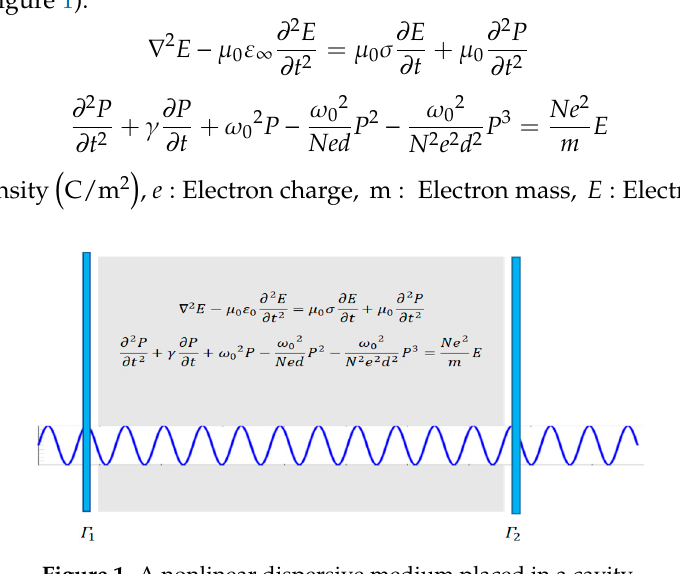
Damping rate : γ = 1 × 10 9 Hz, Electron density : N = 3.5 × 10 28 /m 3 Atomic diameter : d = 0.3